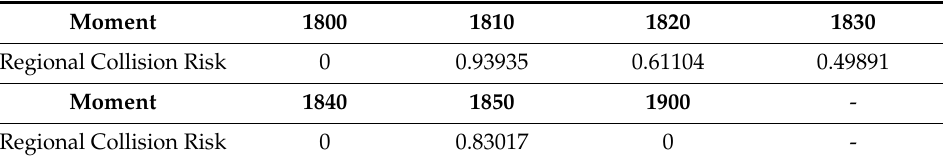
Table 1. Regional collision risk of selected water area.